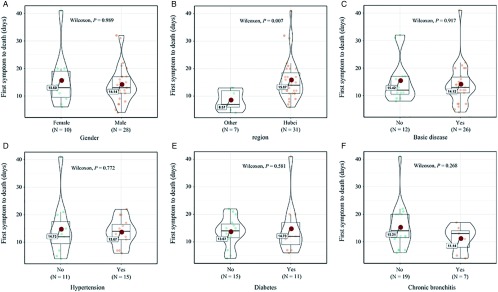
A-F, Comparison of the Influence of Different Factors on the Time of First Symptom to Death (Days). Violin plots for (A) gender, (B) region, (C) fundamental disease, (D) hypertension, (E) diabetes, and (F) chronic bronchitis.